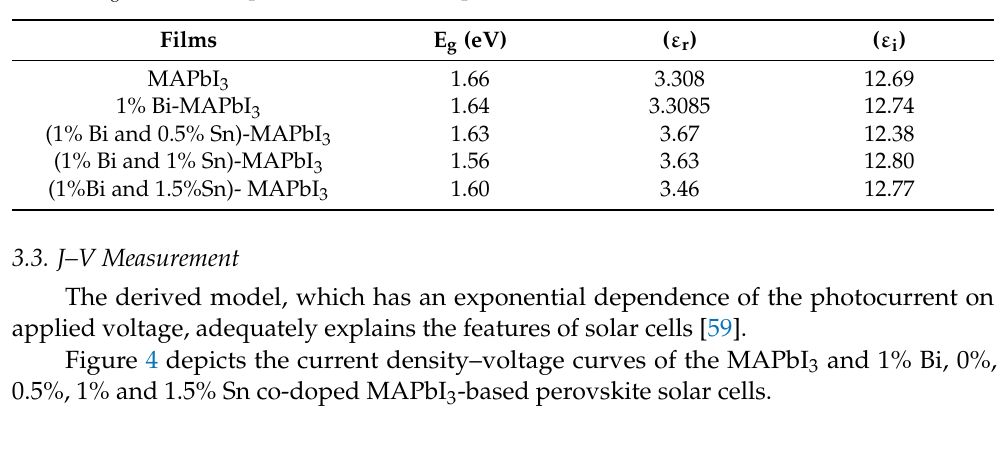
Table 2. E g , ε r and ε i of pure and Bi–Sn co-doped MAPbI 3